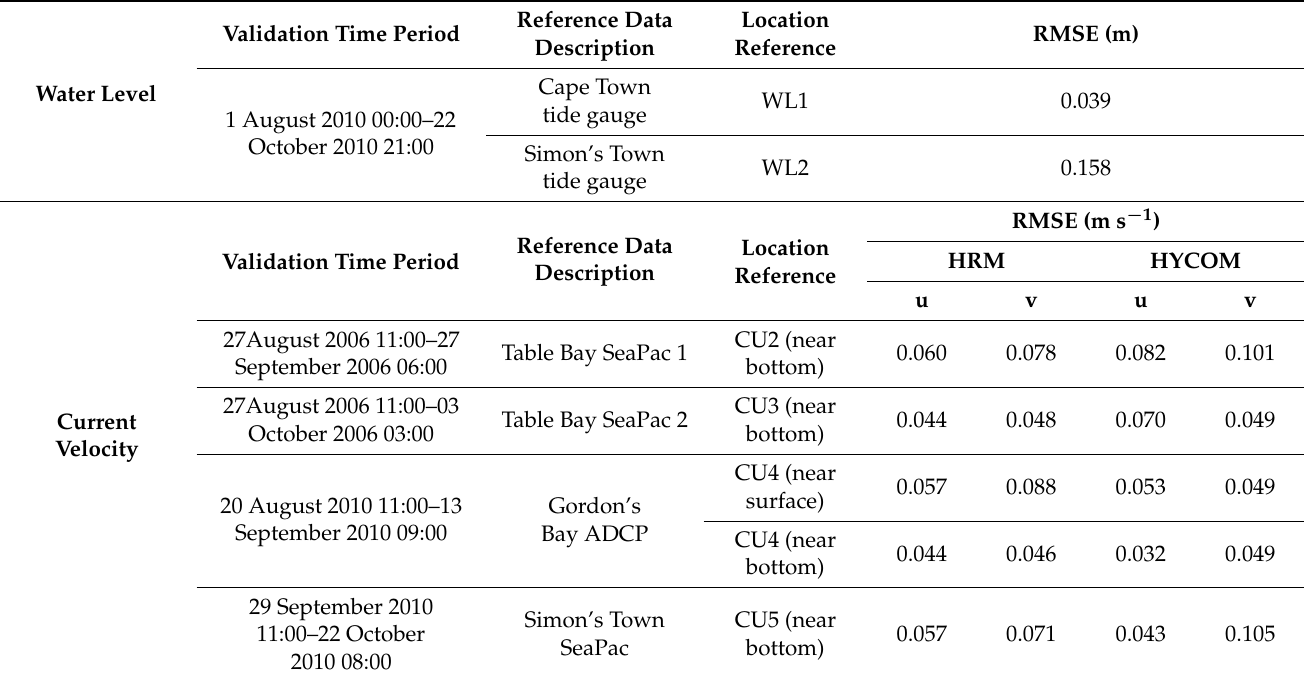
Table A4. Summary of validation statistics. These statistics are produced for all relevant parameters for times and places where measurements were available, excluding those used during